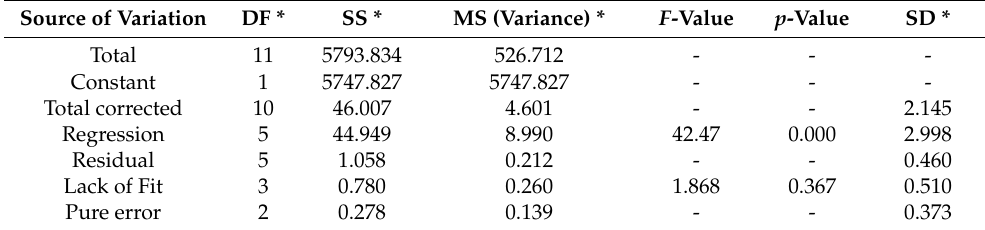
Table 3. Analysis of variance for CaCO 3